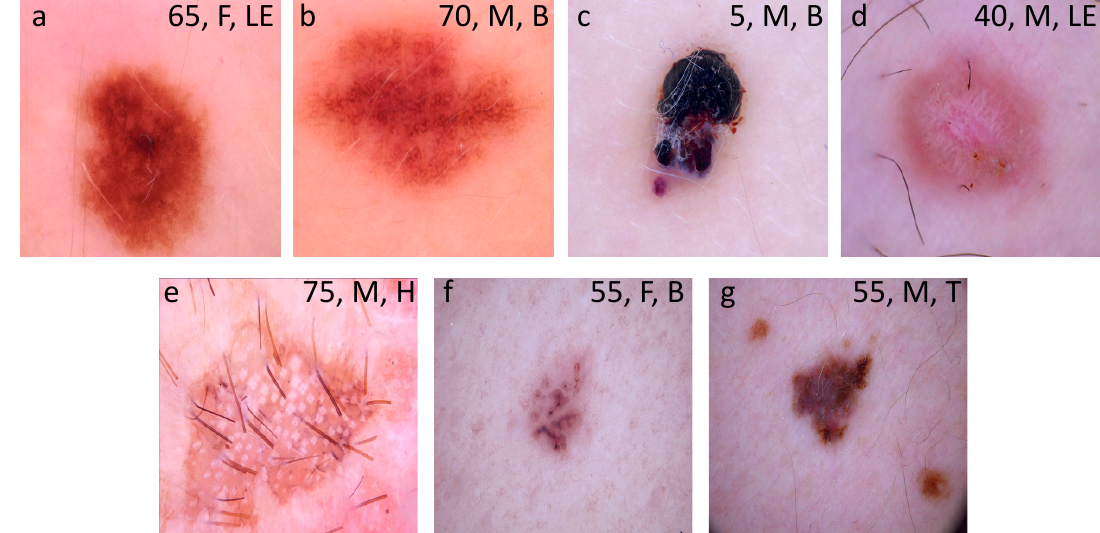
Figure 1. Examples of images downloaded from the HAM10000 dataset. These images are publicly available through the International Skin Imaging Collaboration (ISIC) archive and represent more than 95% of all pigmented lesions encountered during clinical practice (Tschandl P 2018). ( a ) Melanocytic nevus; ( b ) benign keratosis; ( c ) vascular lesion; ( d ) dermatofibroma; ( e ) intraepithelial carcinoma; ( f ) basal cell carcinoma; and ( g ) melanoma. Legends inside each image represents clinical data such as age, sex and localization associated to the image. F: female; M: male; LE: lower extremity; B: back; H: hand; T: trunk.